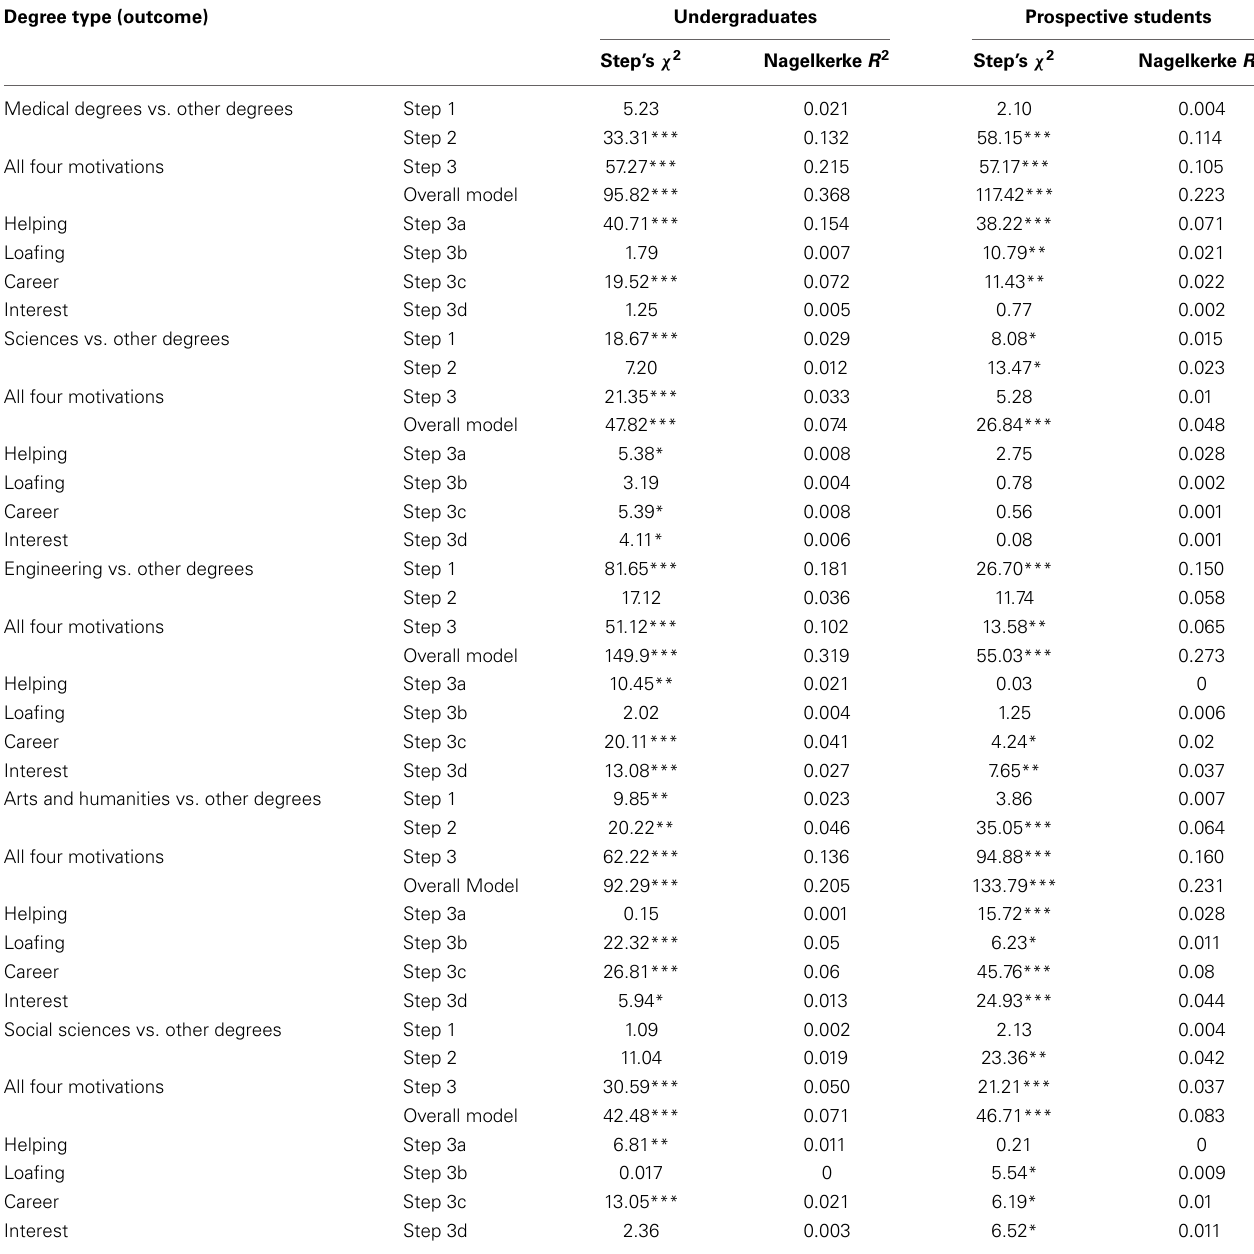
Table 5 | Fit statistics of logistic regression models predicting degree types, Sample 1 (undergraduates) and Sample 2 (prospective students): Step 1, age and gender; Step 2, Aspiration Index scales; Step 3, MICC